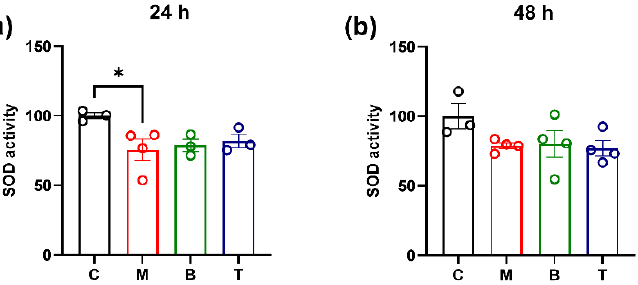
Figure 2. SOD activity after treatment with 10 µ M morphine (M), 0.25 µ M buprenorphine (B) or 10 µ M tapentadol (T) in SH-SY5Y cells at 24 h ( a ) and 48 h ( b ). Data, reported as the mean ± SEM of three/four biological replicates for each treatment, are expressed as the percentage of inhibition rate (absorbance) compared to control (C) and analyzed by one-way ANOVA followed by Dunnett’s multiple comparisons test (* p < 0.05 vs.